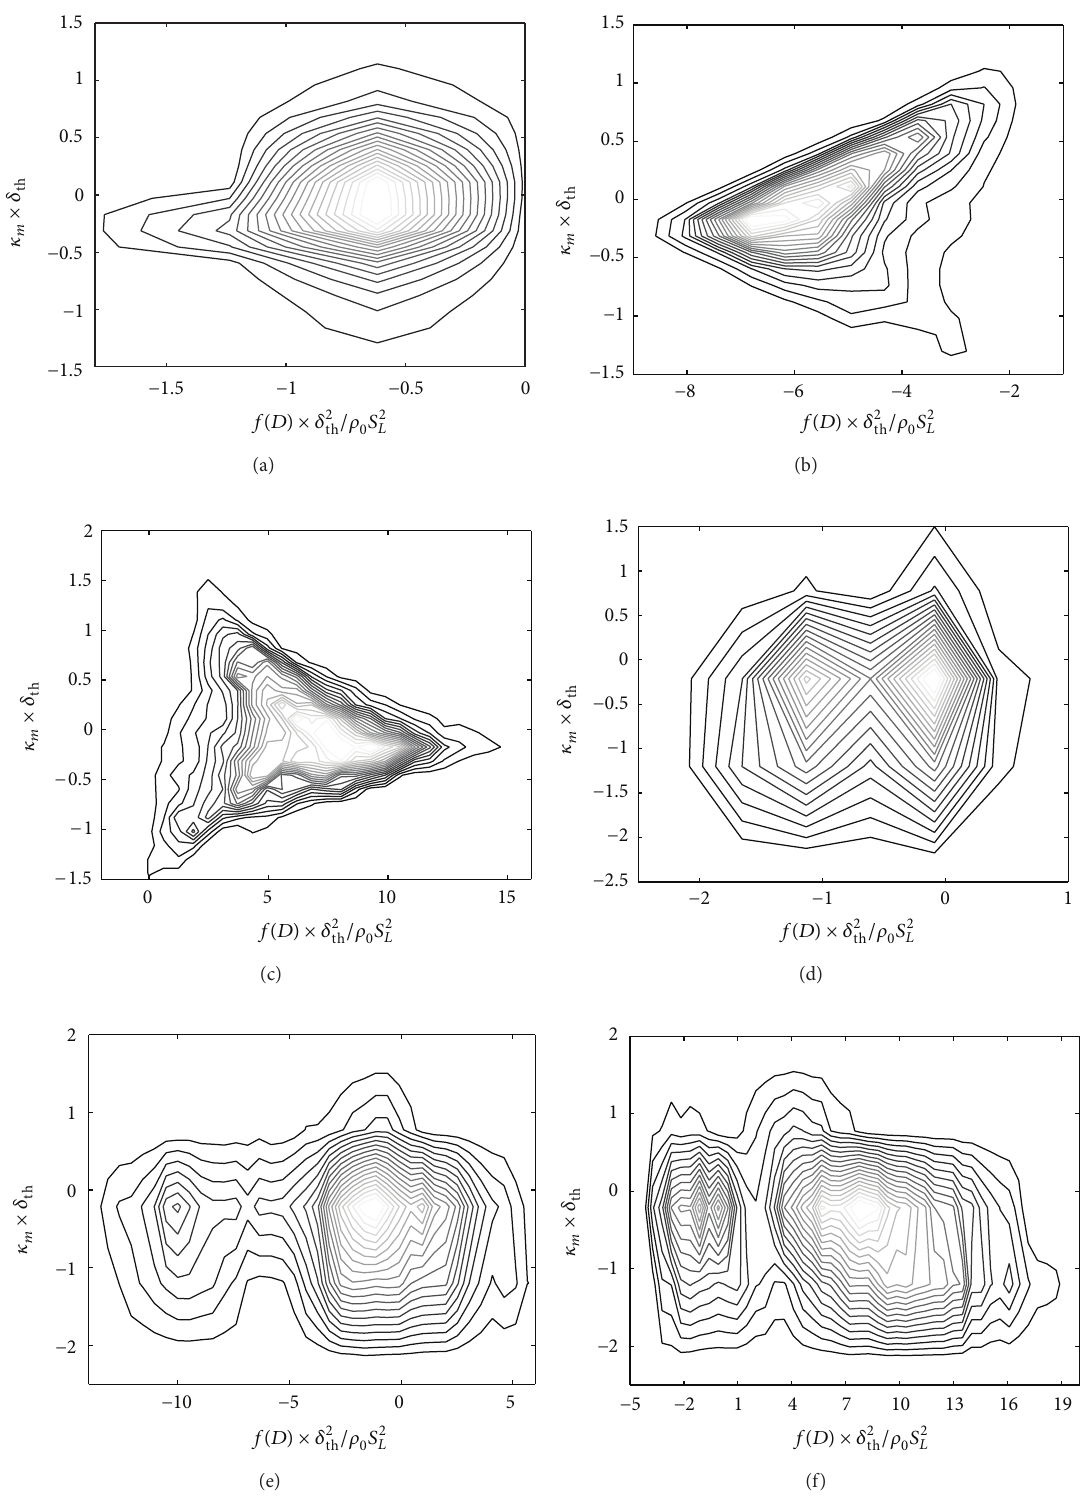
/𝜌 𝑆 2 0 𝐿 and normalised curvature th